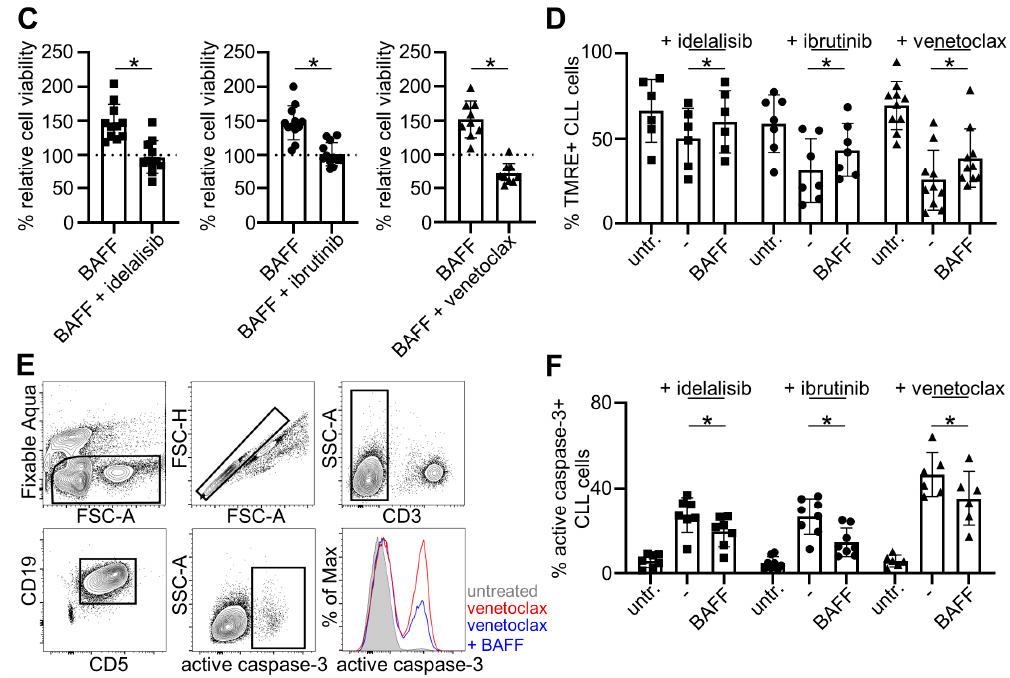
Figure 1. Protection of CLL cells from small molecule inhibitor-induced cell death by BAFF. ( A,B ) Peripheral blood mononuclear cells (PBMC) of CLL patients ( n = as indicated) were exposed to idelalisib (500 nM), ibrutinib (500 nM) or venetoclax (2 nM) in combination with increasing concentrations of recombinant human BAFF (rhBAFF) in the absence ( A ) or presence ( B ) of rituximab (10 µg/mL). Cell viability was determined by measurement of ATP levels using the CTG assay. Results were normalized to the respective untreated samples, and relative viability was calculated. Boxes indicate the median and interquartile range, and whiskers represent data up to 1.5 × the interquartile range. RM one-way ANOVA with Tukey’s multiple comparisons tests were used for statistical analysis. ( C ) PBMC of CLL patients were exposed to rhBAFF in the presence or absence of idelalisib ( n = 11), ibrutinib ( n = 12) or venetoclax ( n = 9) and then analyzed using CTG assays. Results were normalized to respective untreated samples without BAFF exposure (dotted line), and relative viability was calculated. For idelalisib and ibrutinib, a two-tailed t -test and for venetoclax a Wilcoxon matched-pairs signed rank test was used. ( D ) Mitochondrial membrane potential of primary CLL cells in the presence or absence of rhBAFF (500 ng/mL) was determined by staining with TMRE (Sigma, St. Louis, MO, USA) in 7-AAD-CD3- CD5+CD19+ cells using flow cytometry. Combined results of the percentages of TMRE+ primary CLL cells treated with idelalisib (10 µM, n = 7), ibrutinib (10 µM, n = 7) or venetoclax (5 nM, n = 10) are shown. For idelalisib and ibrutinib, a two-tailed t -test and for venetoclax a Wilcoxon matched-pairs signed rank test was used. ( E,F ) Active caspase-3 in Fixable Aqua-CD3-CD5+CD19+ cells in the presence or absence of rhBAFF (500 ng/mL) was determined intracellularly using flow cytometry. In ( E ), an example for the gating strategy is shown; ( F ) depicts combined results of the percentages of active caspase-3+ primary CLL cells treated with idelalisib (50 µM, n = 7), ibrutinib (10 µM, n = 8) or venetoclax (7.25 nM, n = 6). A two-tailed t -test was used for statistical analysis. Statistically significant differences ( p < 0.05) are indicated by *.